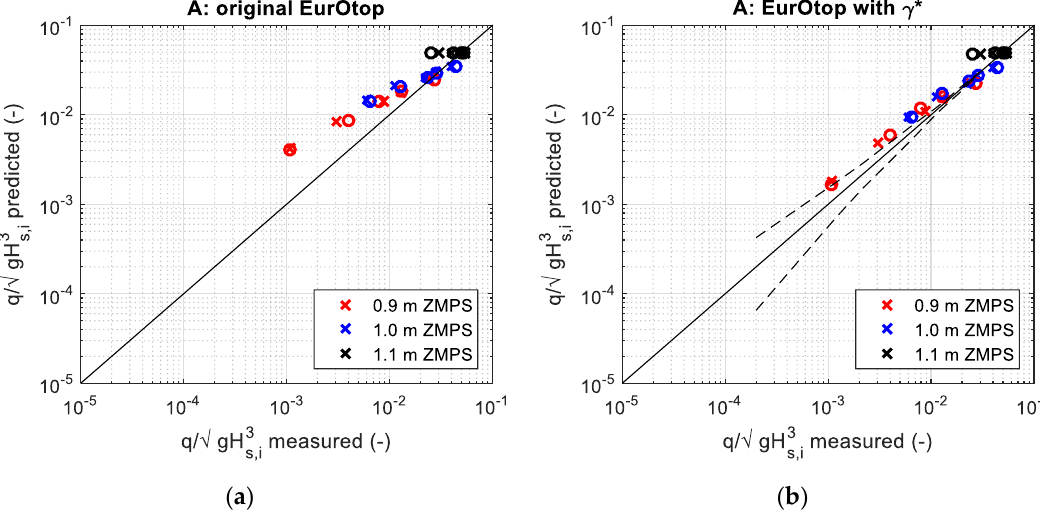
Figure 11. Measured overtopping and predictions for the cross-sections A: according to EurOtop ( a ), applying γ * ( b ). Crosses (x) are relative to S op = 0.063, circles (o) are relative to S op = 0.048. Dashed lines are the upper and lower 95% prediction bounds.